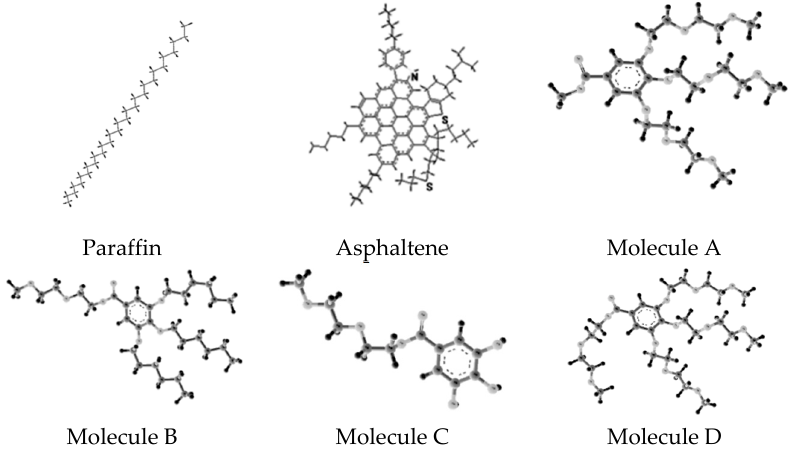
Figure 1. Initial structures considered.